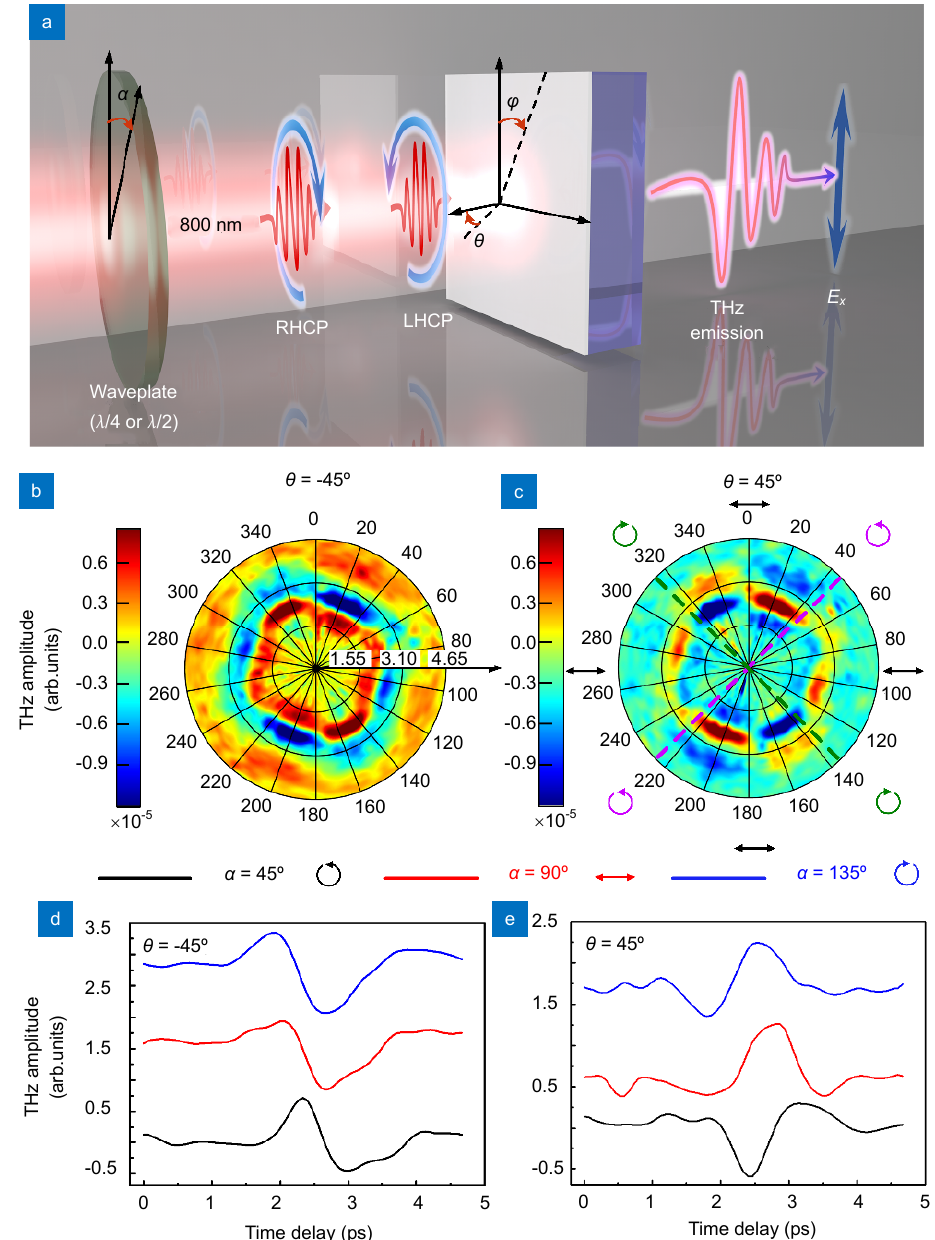
Fig. 3 | ( a ) Schematic of the THz emission configuration. Polar plots of terahertz waveforms (0~4.65 ps) as a function of α at ( b ) θ = -45º and ( c ) +45º, respectively, for φ = 0º. The colors represent the amplitude of the terahertz emissions. Terahertz waveforms for excitation with left-hand circularly polarized, linearly polarized, and right-hand circularly polarized optical pulses at ( d ) θ = -45º and ( e ) +45º,